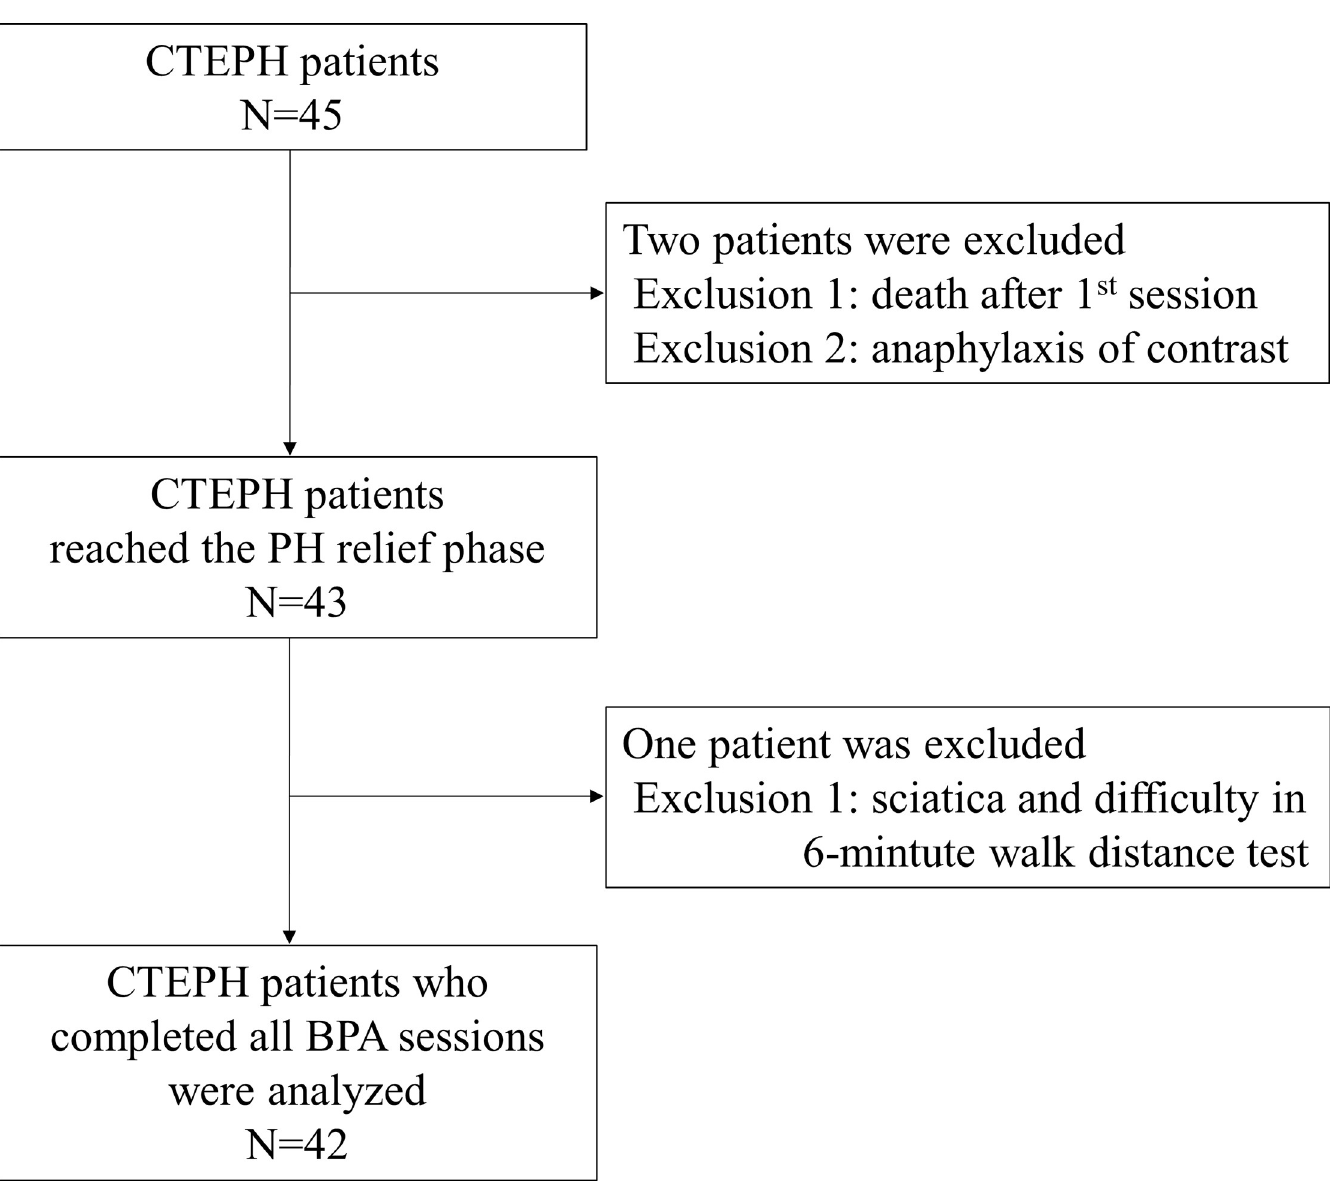
Fig 2. Study flow chart. BPA, balloon pulmonary angioplasty; CTEPH, chronic thromboembolic pulmonary hypertension; PH, pulmonary hypertension. The PH relief phase: The first time a mean pulmonary artery pressure � 25 mmHg or pulmonary vascular resistance � 240 dyn-s/cm 5 was reached before each subsequent BPA